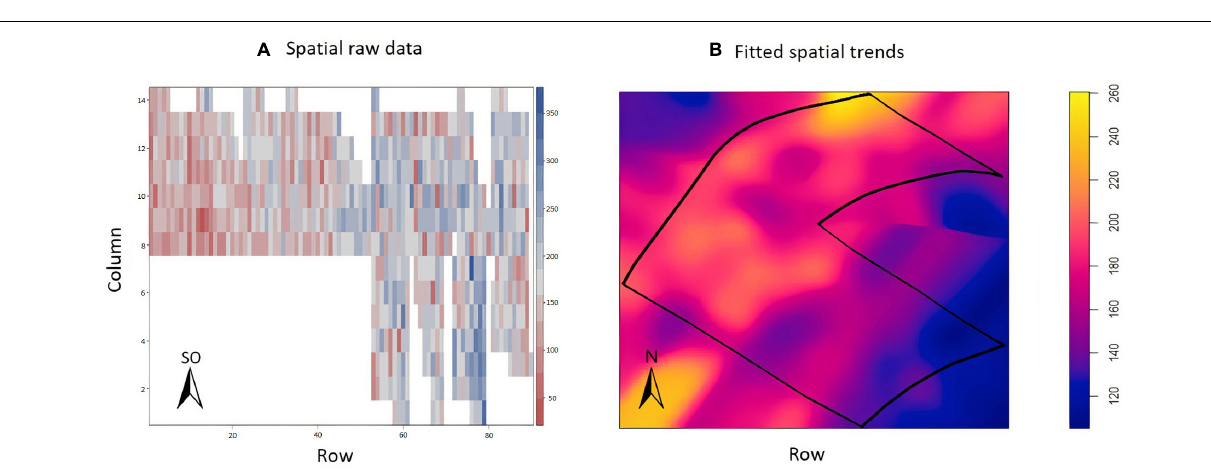
FIGURE 5 | Apparent electrical conductivity (ECa) map and overlap of the experimental plots on the ECa map with 16,617 reading points and the average values of the points of interest in the 0.375 m (A) and 0.75 m (B) layers, Experimental Area 2.